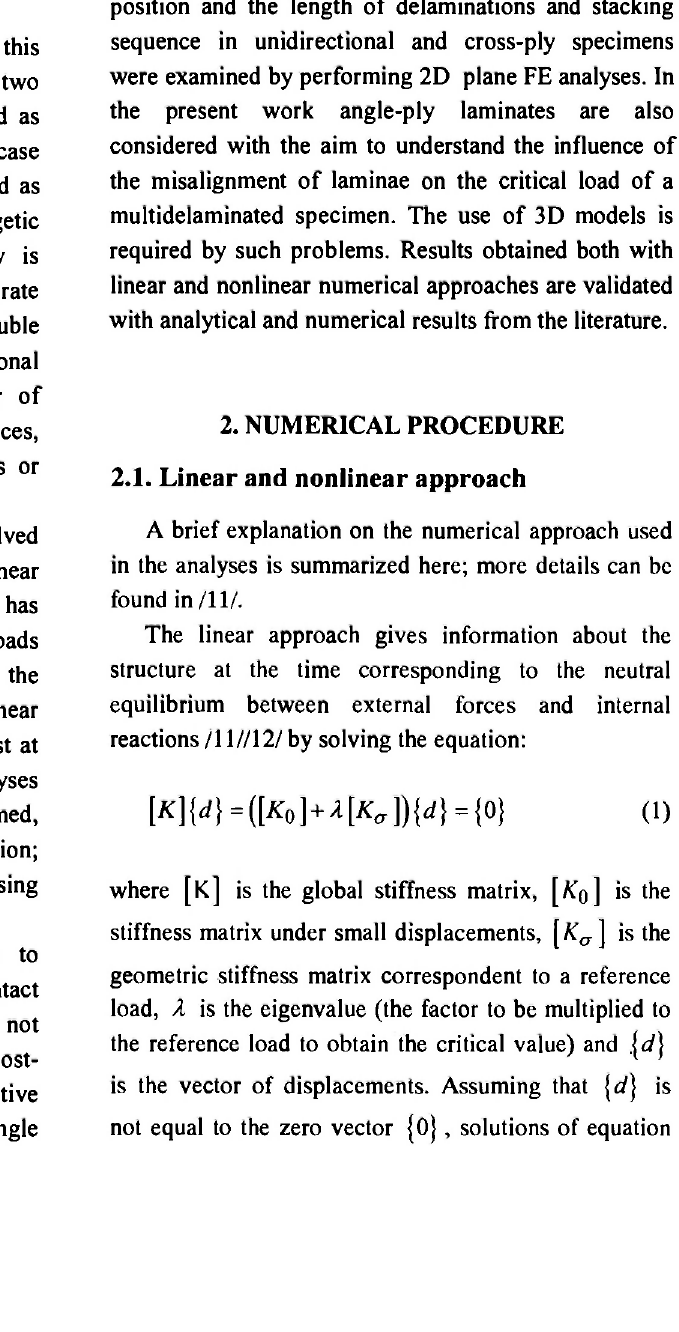
Fig. 1: Mode of buckling: (a) global, (b) local, (c,d)